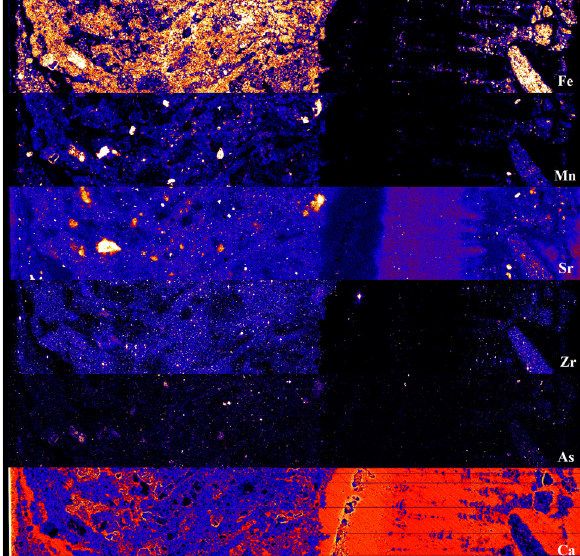
Figure 7: Synchrotron X-ray fluorescence data showing the correlation of iron (Fe) with manganese (Mn) and arsenic (As) versus the structure of the calcite (Ca; calcium) in the flowstone. The high Fe portion on the left of the specimen represents a thick flood layer within the flowstone. In the right-hand side of the specimen, large Fe-rich sediment clasts can be seen occurring within the Ca-rich portion of the flowstone. In the lower section, Fe can also be seen occurring as another thinner layer within the flowstone, as well as along crystal boundaries. (Note: the darker the image the less there is of each element.) Fe is quite regularly distributed within the Haasgat flowstones (Figure 6) and as such the remanence of standard 25-mm palaeomagnetic cores is measuring the remanence of multiple flood events. In contrast to the calcified sediments which hold a post-depositional remanent magnetisation formed after dewatering and compaction of the sedi- ments, the remanence in speleothem is a true depositional remanent